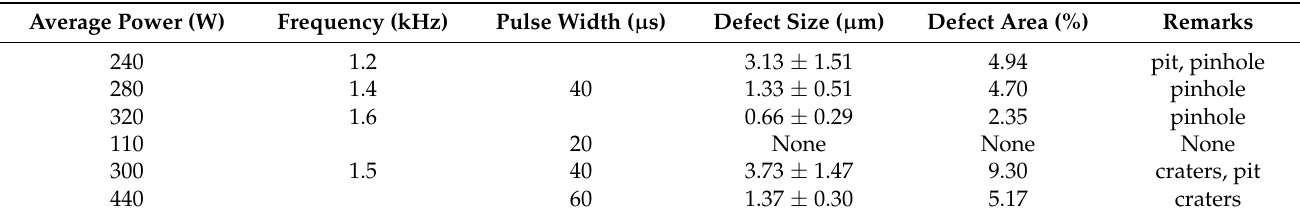
Table 3. Deposition parameters, defect size, and area distribution along with defect type on the coating surface prepared by